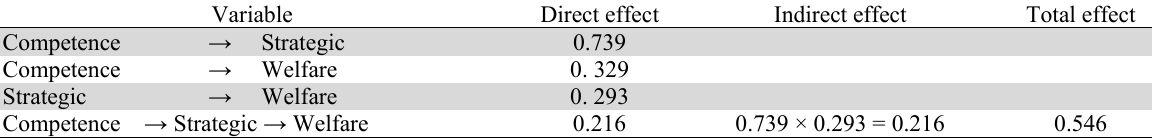
Test Results Influence of competence on welfare through business